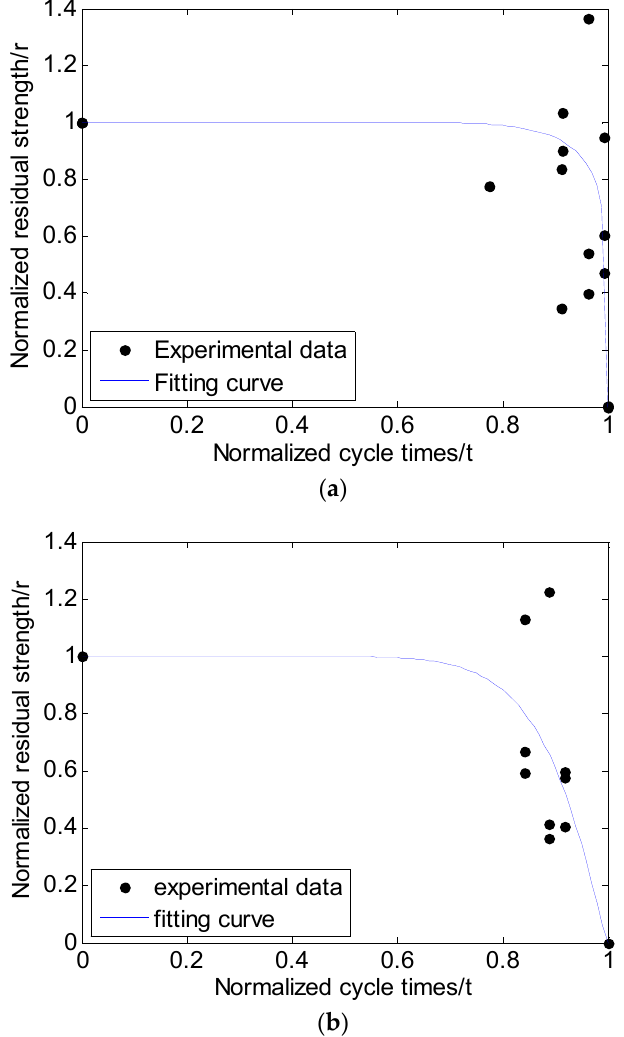
Figure 8. Residual strength curves and the experimental data in the principal direction at 600 °C.